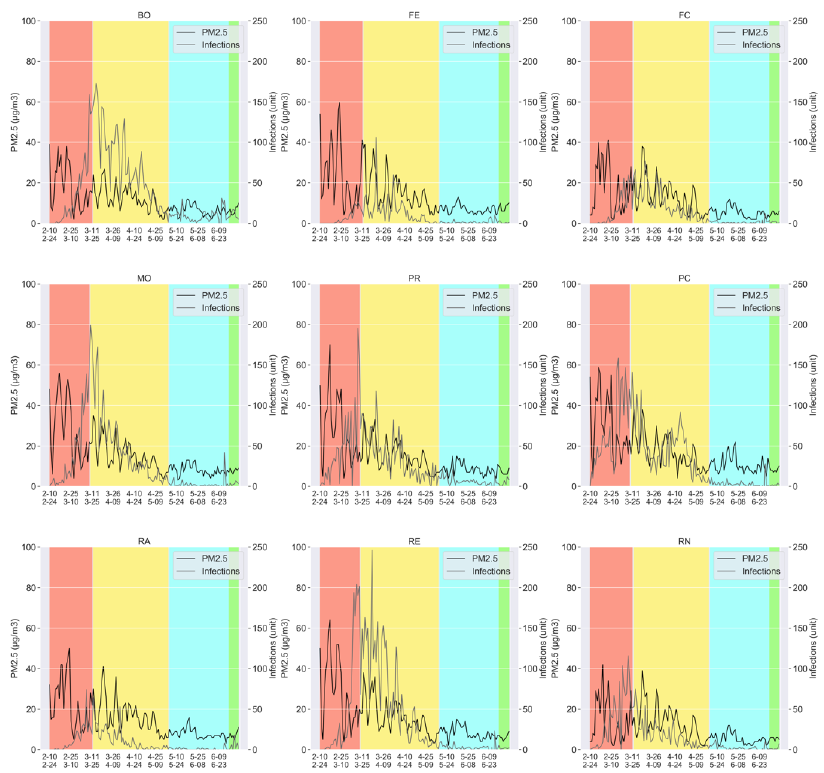
Figure 4. The dataset (III): infections, pollutant (PM 2.5 ), and phases.